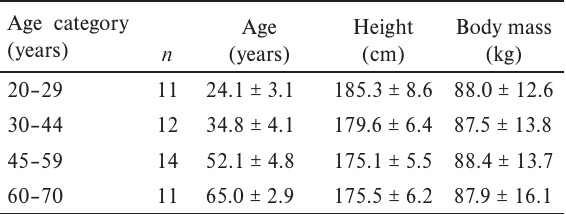
Characteristics of sedentary subjects (mean ±